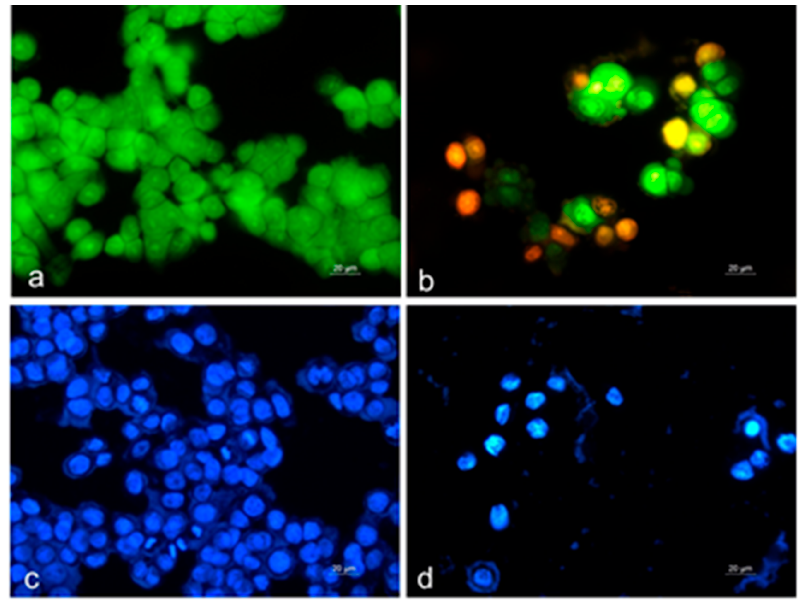
Figure 4. Cytomorphological alterations induced by the extract of in vitro cultures of C. vulgare in HT-29 colorectal carcinoma cells. ( a , c ) Control untreated cells; ( b , d ) cells treated with C. vulgare extract. ( a , b ) AO/EB staining; ( c , d ) DAPI staining; fluorescence microscopy; objective 40×.